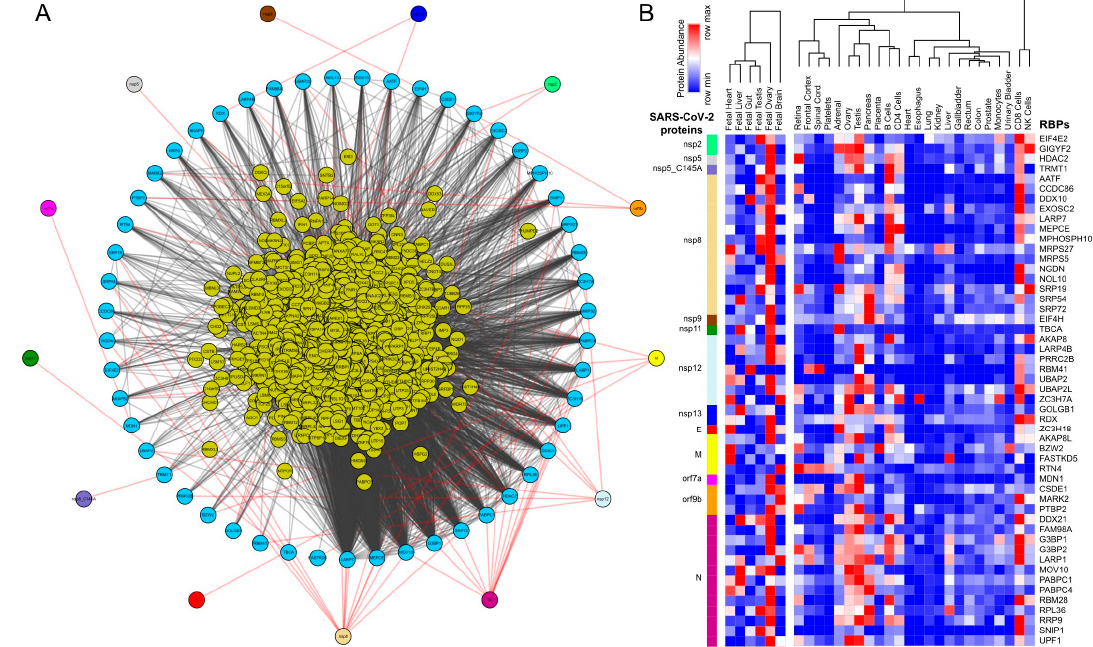
Figure 1. Protein ‐ protein interaction network analysis suggests a direct interaction of human RNA ‐ binding proteins (RBPs) with SARS ‐ CoV ‐ 2 viral proteins ( A ) An integrated SARS ‐ CoV ‐ 2—human RBP interaction network. We obtained the mass spectrometry (MS) ‐ based SARS ‐ CoV ‐ 2 viral protein to the human protein interaction network established in HEK293 cells and integrated with first ‐ neighbor ‐ interacting RBPs (obtained from BioGRID—https://thebiogrid.org). ( B ) Protein abundance of SARS ‐ CoV ‐ 2 ‐ interacting RBPs across human tissues. Expression data was obtained from the human protein map and row normalized. SARS ‐ CoV ‐ 2 proteins were color ‐ coded and highlighted in the network.